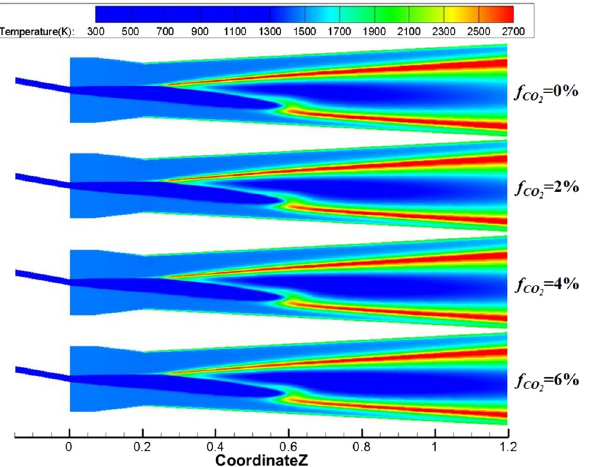
Figure 6: Distribution of temperature fi eld on YZ plane in a furnace with di ff erent f in the hot blast. CO 2